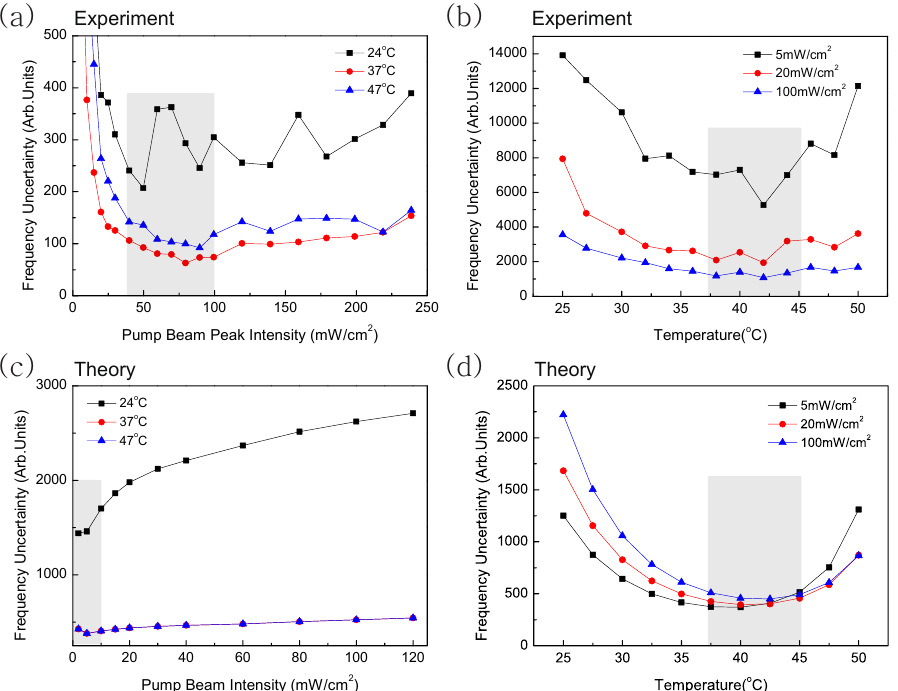
Figure 5. Lower limit of the frequency uncertainty of polarization spectroscopy signal of 87 Rb F g = 2 F e = 3 transition line on the change of vapor cell temperature and pump beam intensities. → Further, ( a , b ) show the experimental results of the lower limit of frequency uncertainty, and ( c , d ) show the theoretical results. The frequency uncertainty has an arbitrary unit. The gray shaded region represents the minimum values of the lower limit of the frequency